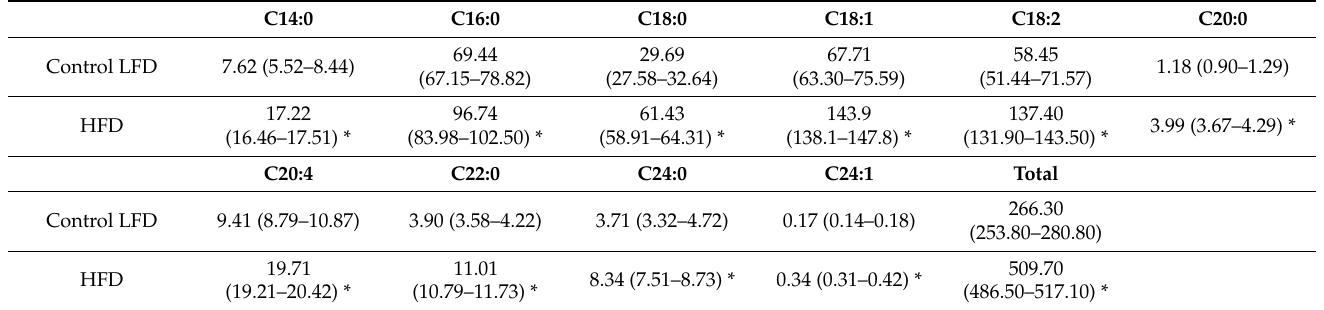
Table 1. Impact of High-Fat Diet Consumption on Plasma Free-Fatty Acid Concentration.